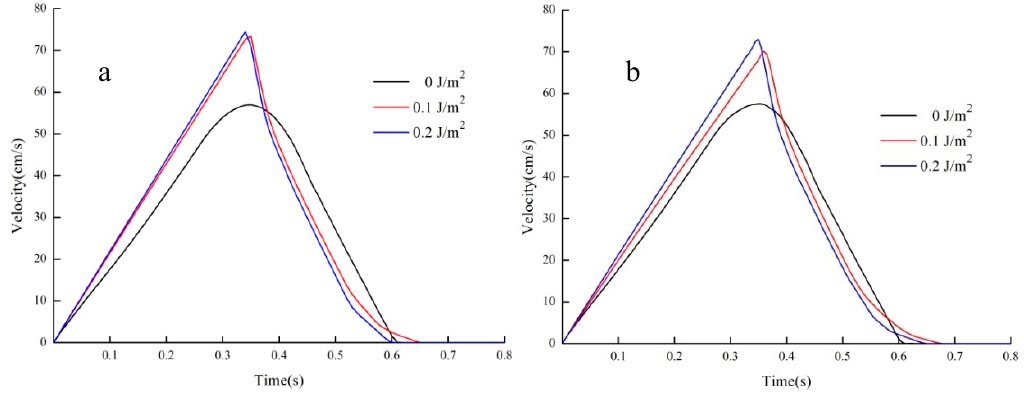
Figure 7. The total velocity of the wet soil granular flow, the ( a ) and ( b ) diagrams represent results of soil-grain diameters of 0.7 mm and 1 mm respectively.